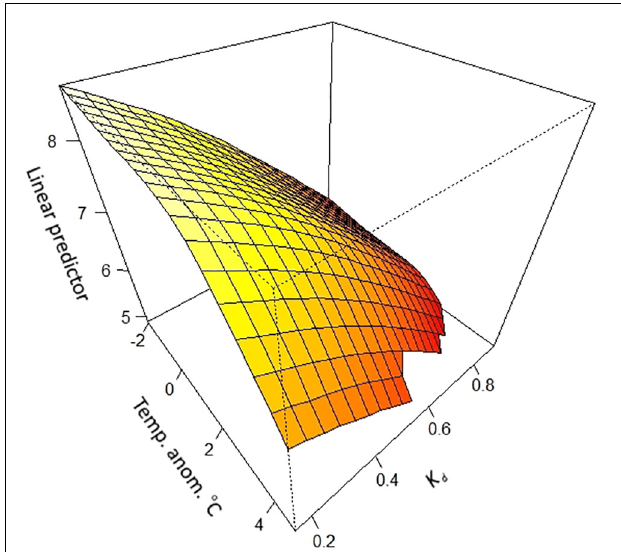
FIGURE 6 | Interactive effects of temperature anomalies and light attenuation on surface canopy cover of Macrocystis pyrifera across New Zealand. Plot shows the mean response. Contours show the mean response of kelp coverage to each variable, extrapolated 25% beyond available data. Contour plots fitted by general additive models